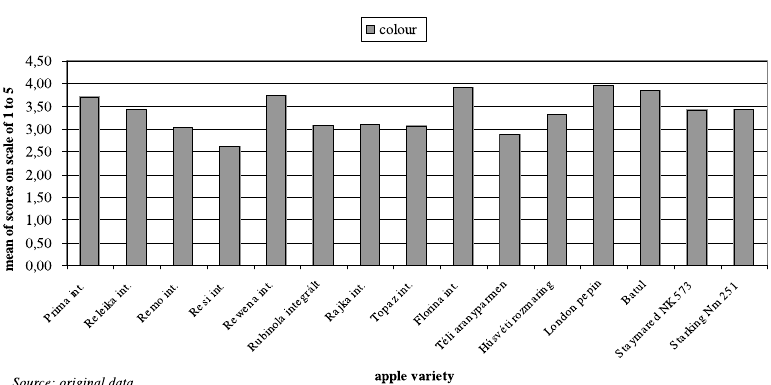
Figure 1: Mean values given to the colour of apple samples